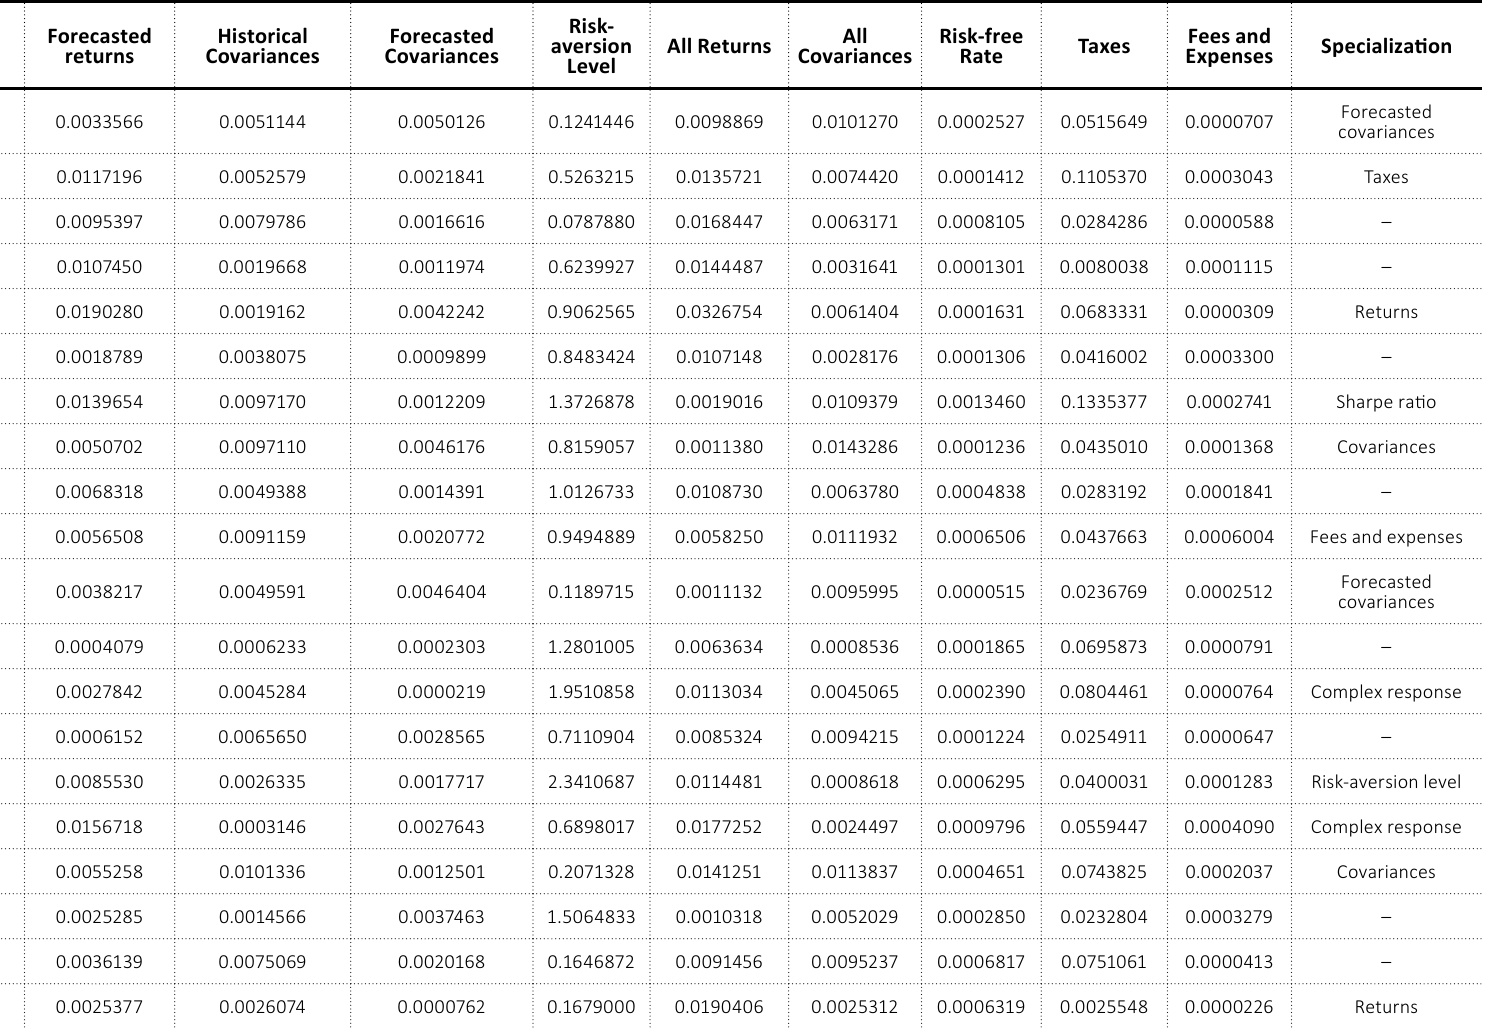
Table A1. Neurons elasticities (in percentages) to 1% change in the